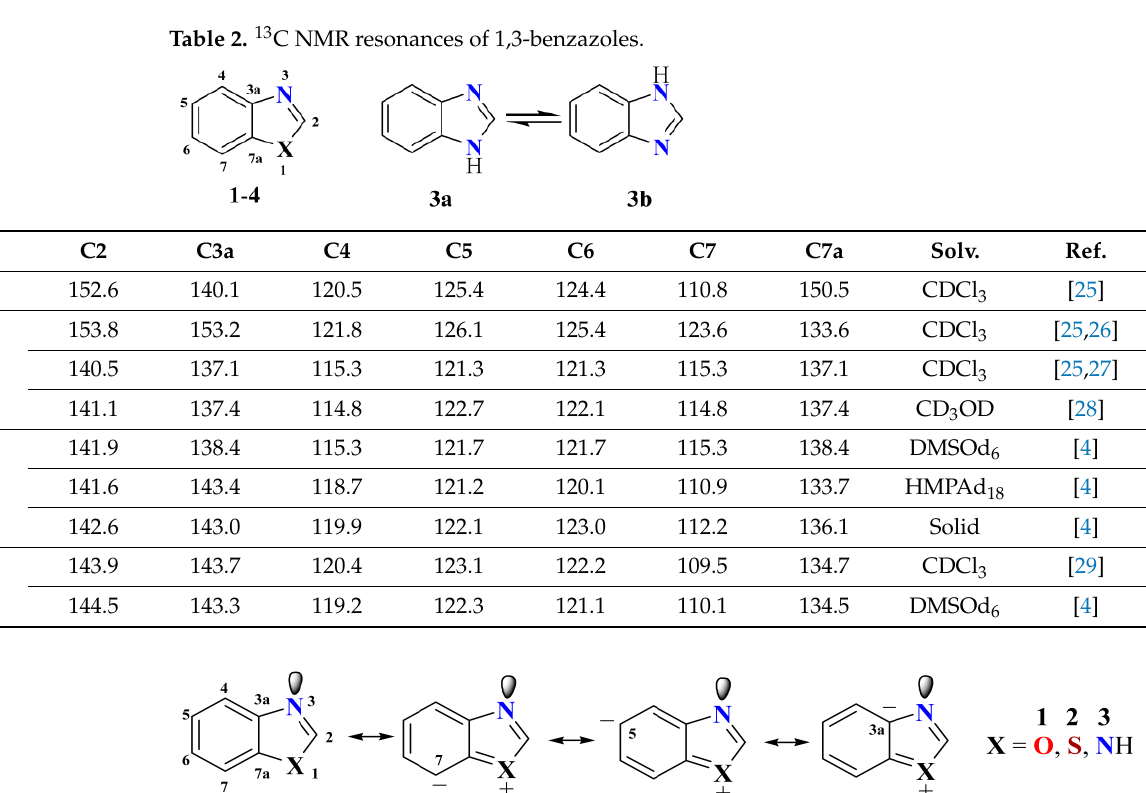
Figure 2. Effect of heteroatom X on C7 and C5 in 1,3-benzoheterazoles 1 – 3 .